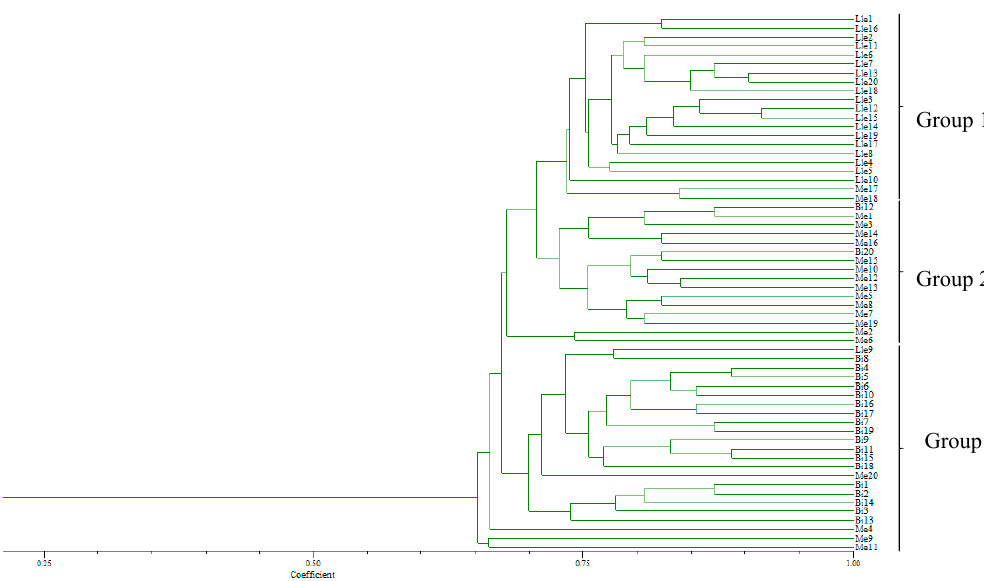
Figure 2. Unweighted pair group method with arithmetic mean (UPGMA) dendrogram using distance of Nei [27] showing the molecular relationships using seven inter simple sequence repeat (ISSR) between 60 plants from three Spanish Amaranthus palmeri populations. Lle1–Lle20: plants from Lleida; Me1–Me20: plants from Menàrguens; Bi1–Bi20: plants from Binéfar. Finally, there were three plants that were not found among the previously described groups (Figure 2, bottom part). All of them were sampled in the locality of Menàrguens.